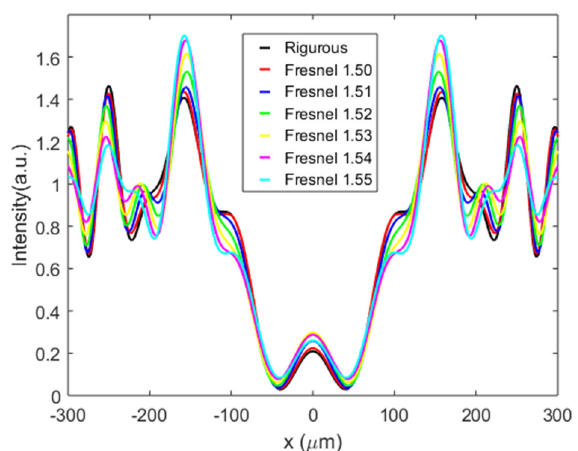
Figure 11. Intensity of the diffraction pattern as function of the distance to the center of the diffraction pattern for a dielectric cylinder with internal radius a = 60 µm and a refractive index of 1.50, 1.51, 1.52, 1.53, 1.54, 1.55.